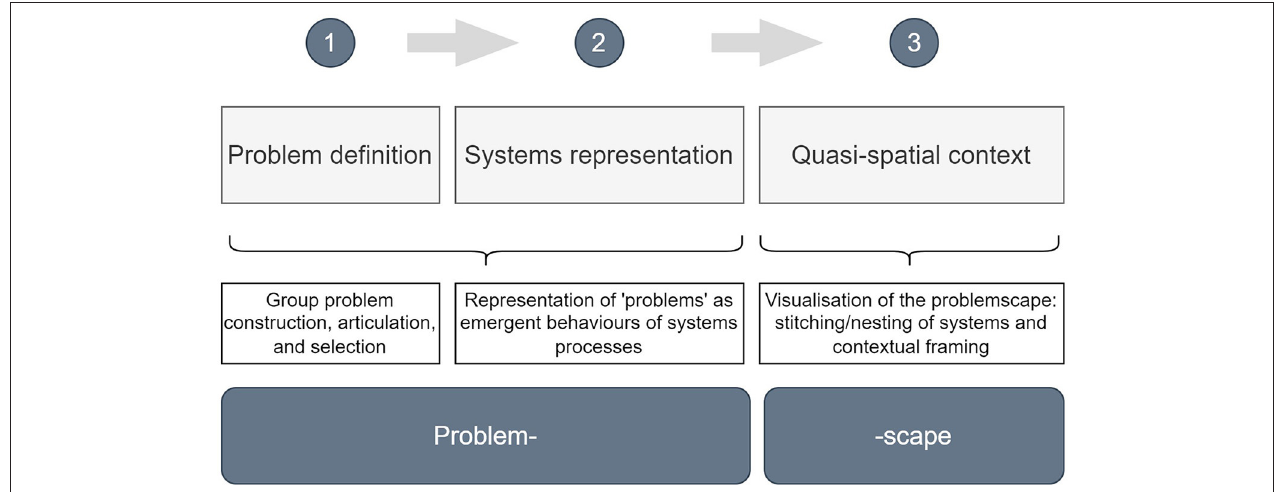
FIGURE 1 | The problemscape methodology.